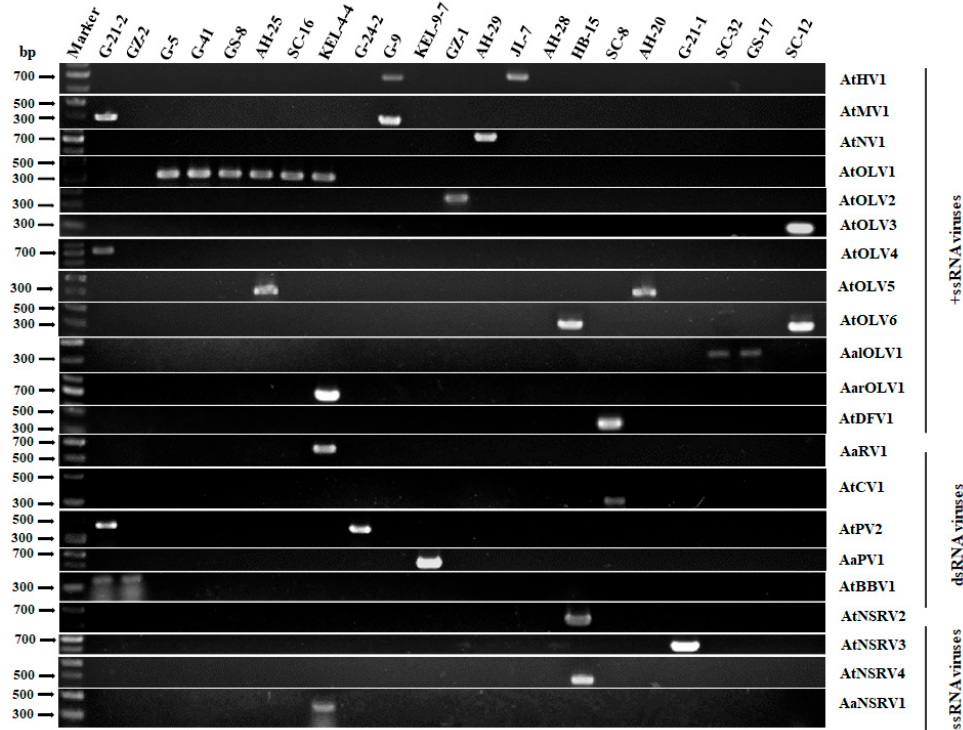
Figure 1 Figure 1. Detection of the 21 putative mycoviruses in different strains by RT-PCR. We used the assembled contigs to design the specific primers (see Supplementary Table S2). Only 22 strains of Alternaria species used for high-throughput sequencing were detected viruses. Lane Marker, DNA Marker II (TianGEN, Beijing, China). For abbreviations of virus names used in detection of the viruses, see Table